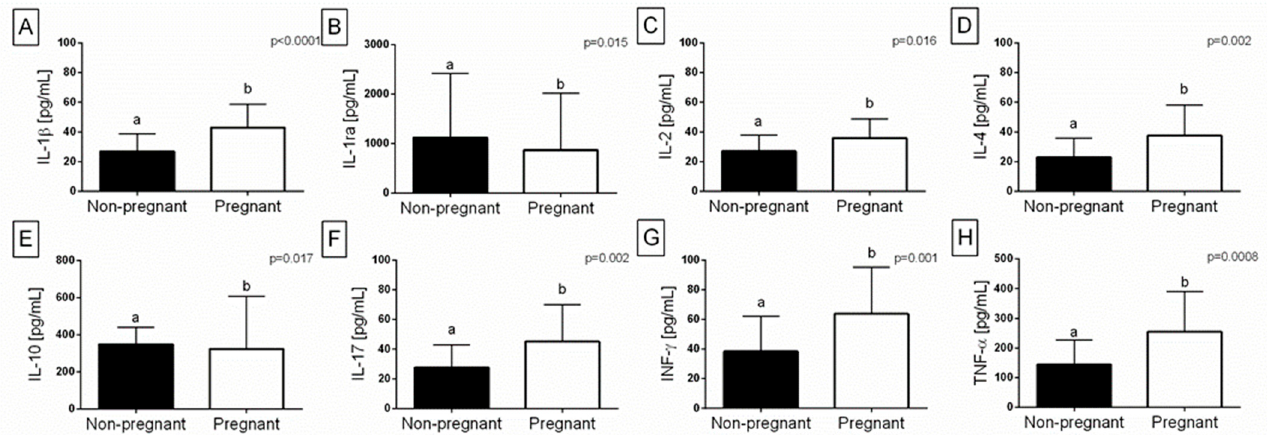
Figure 1. The concentration (mean + SD) of ( A ) interleukin 1ß (IL-1ß), ( B ) interleukin 1ra (IL-1ra), ( C ) interleukin 2 (IL-2), ( D ) interleukin 4 (IL-4), ( E ) interleukin 10 (IL-10), ( F ) interleukin 17 (IL-17), ( G ) interferon γ (INF- γ ), and ( H ) tumor necrosis factor α (TNF- α ) in the mares’ blood representing two groups—the non-pregnant and pregnant mares. Different letters indicate differences between groups ( p < 0.05).